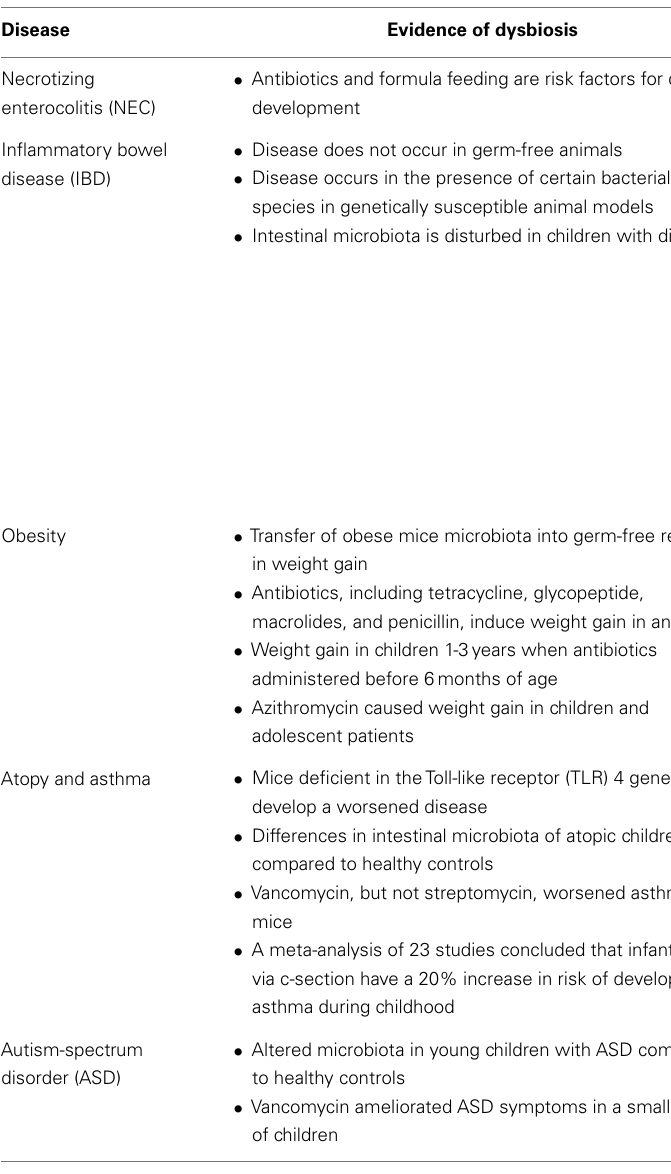
Table 1 | Intestinal microbial dysbiosis in pediatric diseases